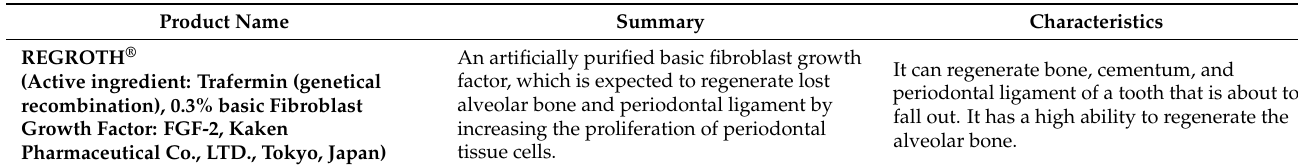
Table 2. Periodontal Tissue Regeneration Materials Used in Periodontal Tissue Regeneration